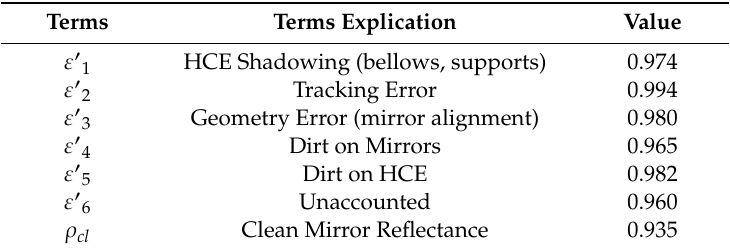
Table 3. Estimates of optical e ffi ciency terms